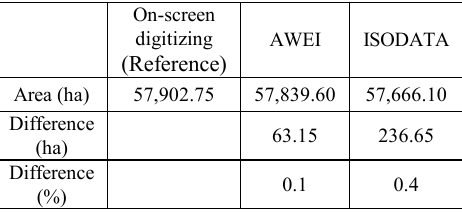
Table 3. Length difference results